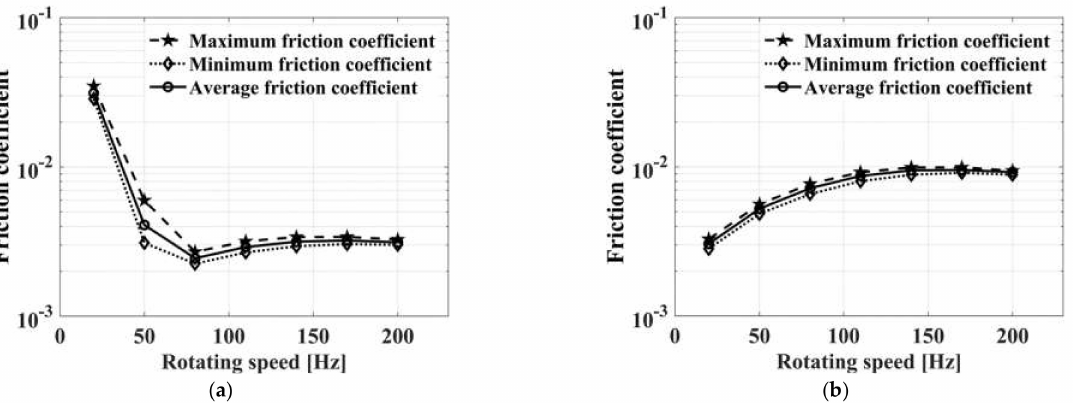
Figure 8. Friction coefficients of an upper bearing ( a ) and lower bearing ( b ) in case of maximum, minimum, and